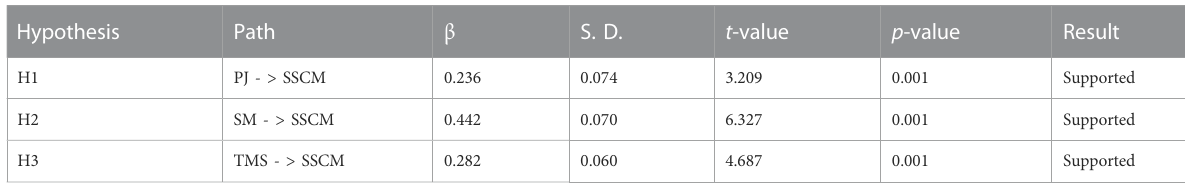
TABLE 4 Hypothesis outcome.